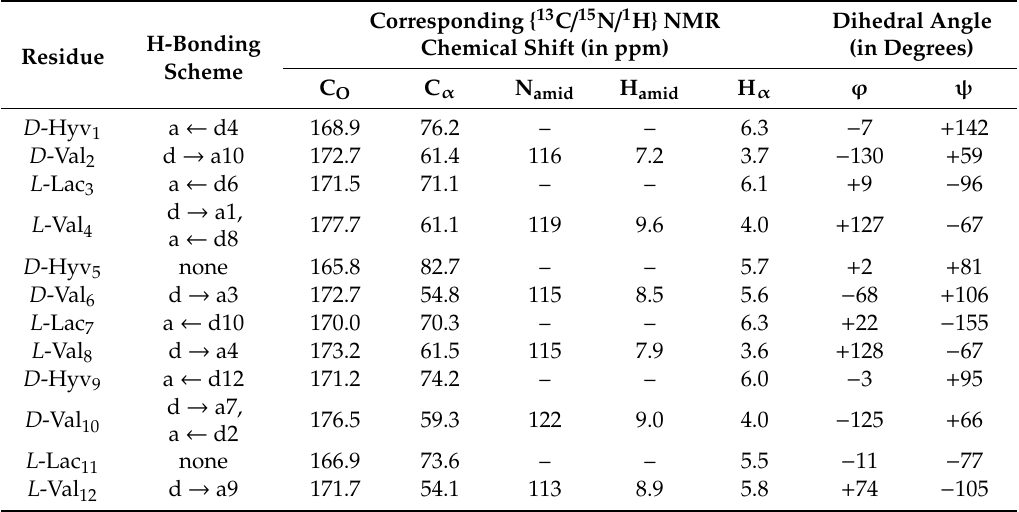
Table 2. The PW PBE structural and spectral parameters of the monoclinic crystalline phase of VLM.